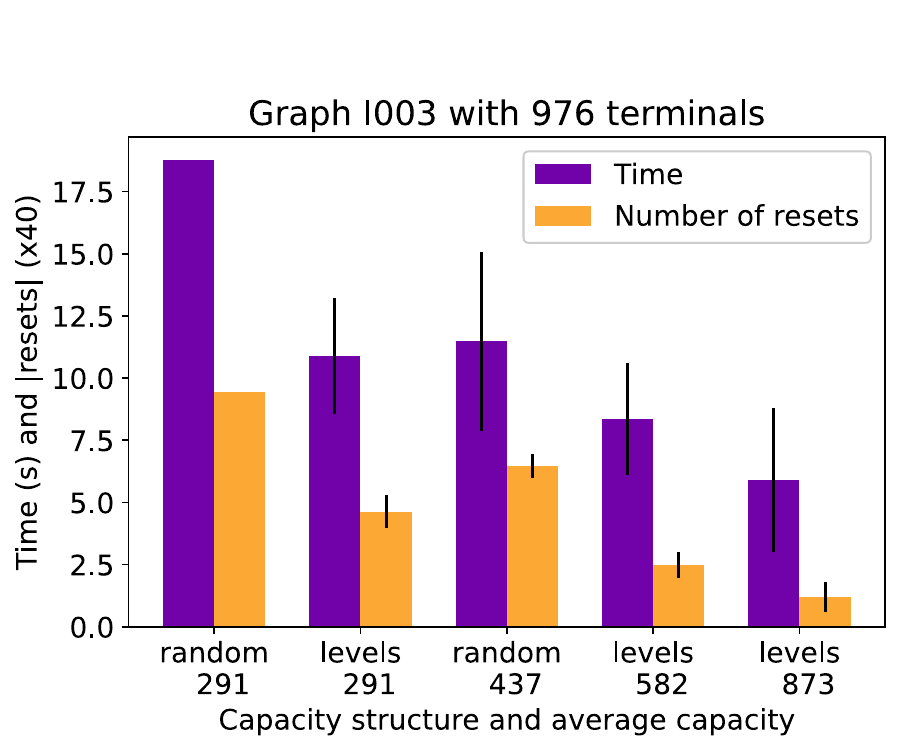
Fig 11. Vienna I003 time compared by capacity. The time (purple bars) and number of resets (yellow bars) for 5 different capacity settings.